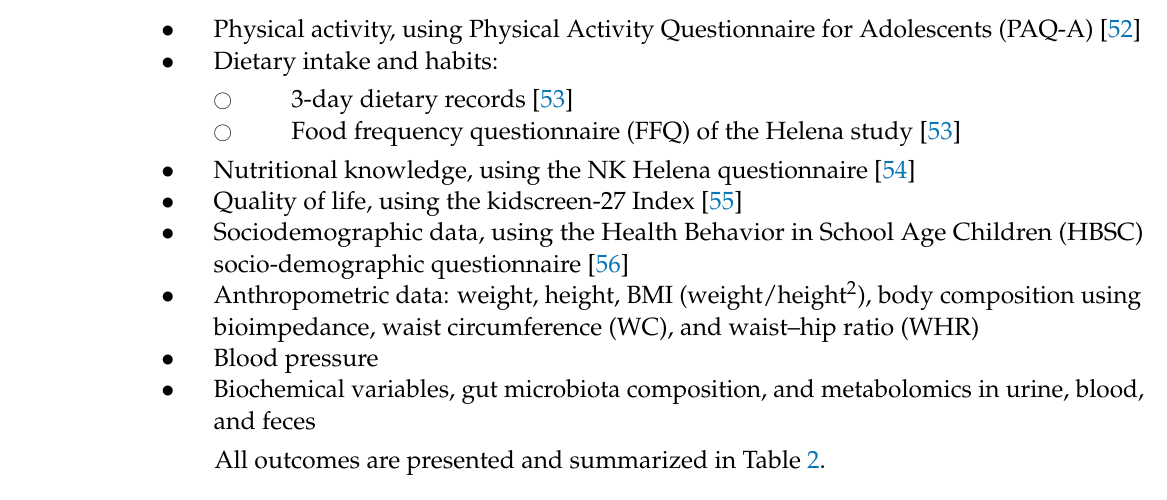
Table 2. Variables to be